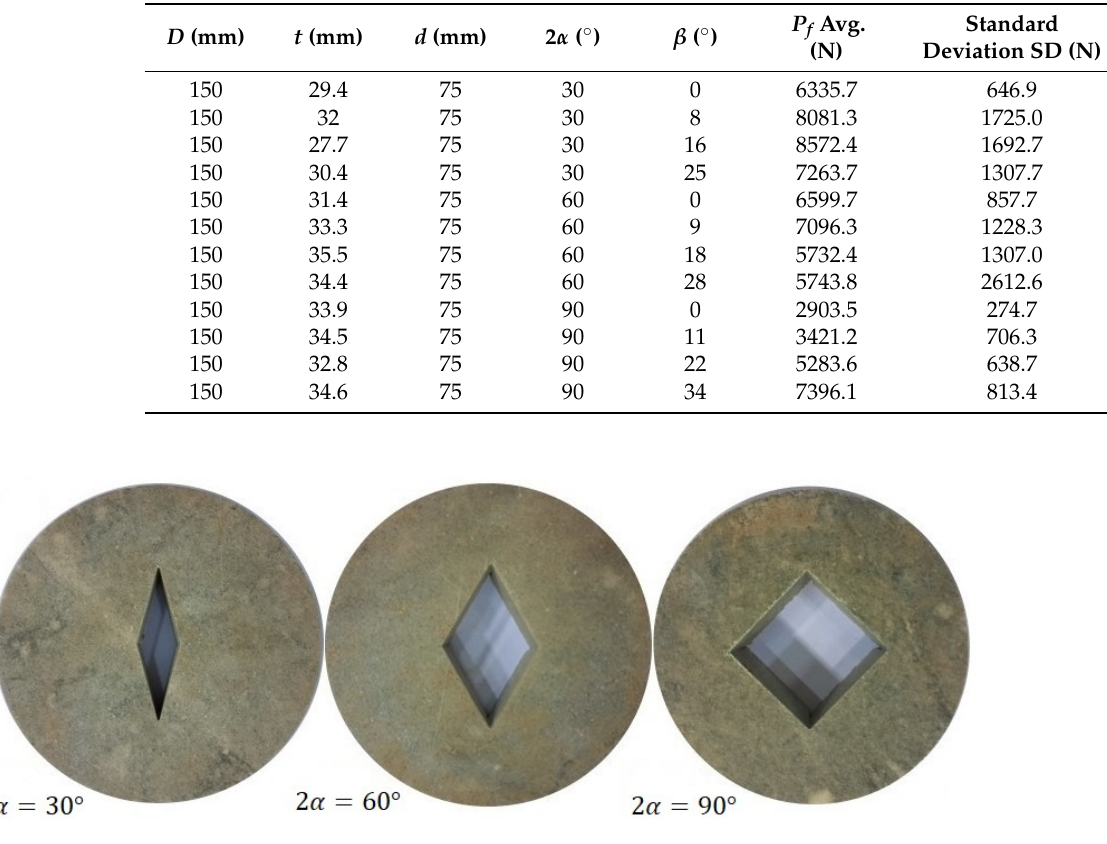
Figure 2. SVNBD samples with notch angles (2 α ) of 30°, 60° and 90° manufactured for mixed-mode fracture tests.